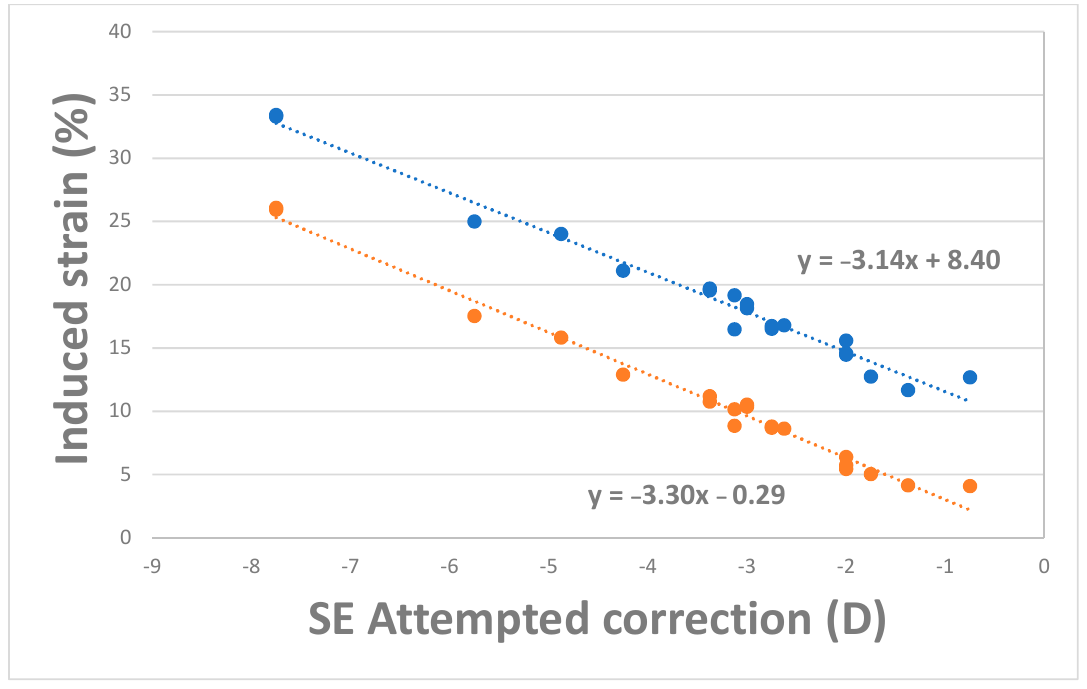
Figure 3. Post-surgical increase (given as a percentage) in average MPS as a function of SE of the correction for LASIK (blue) and PRK (orange), SE: spherical equivalent (diopters), MPS: Maximum principal strain.